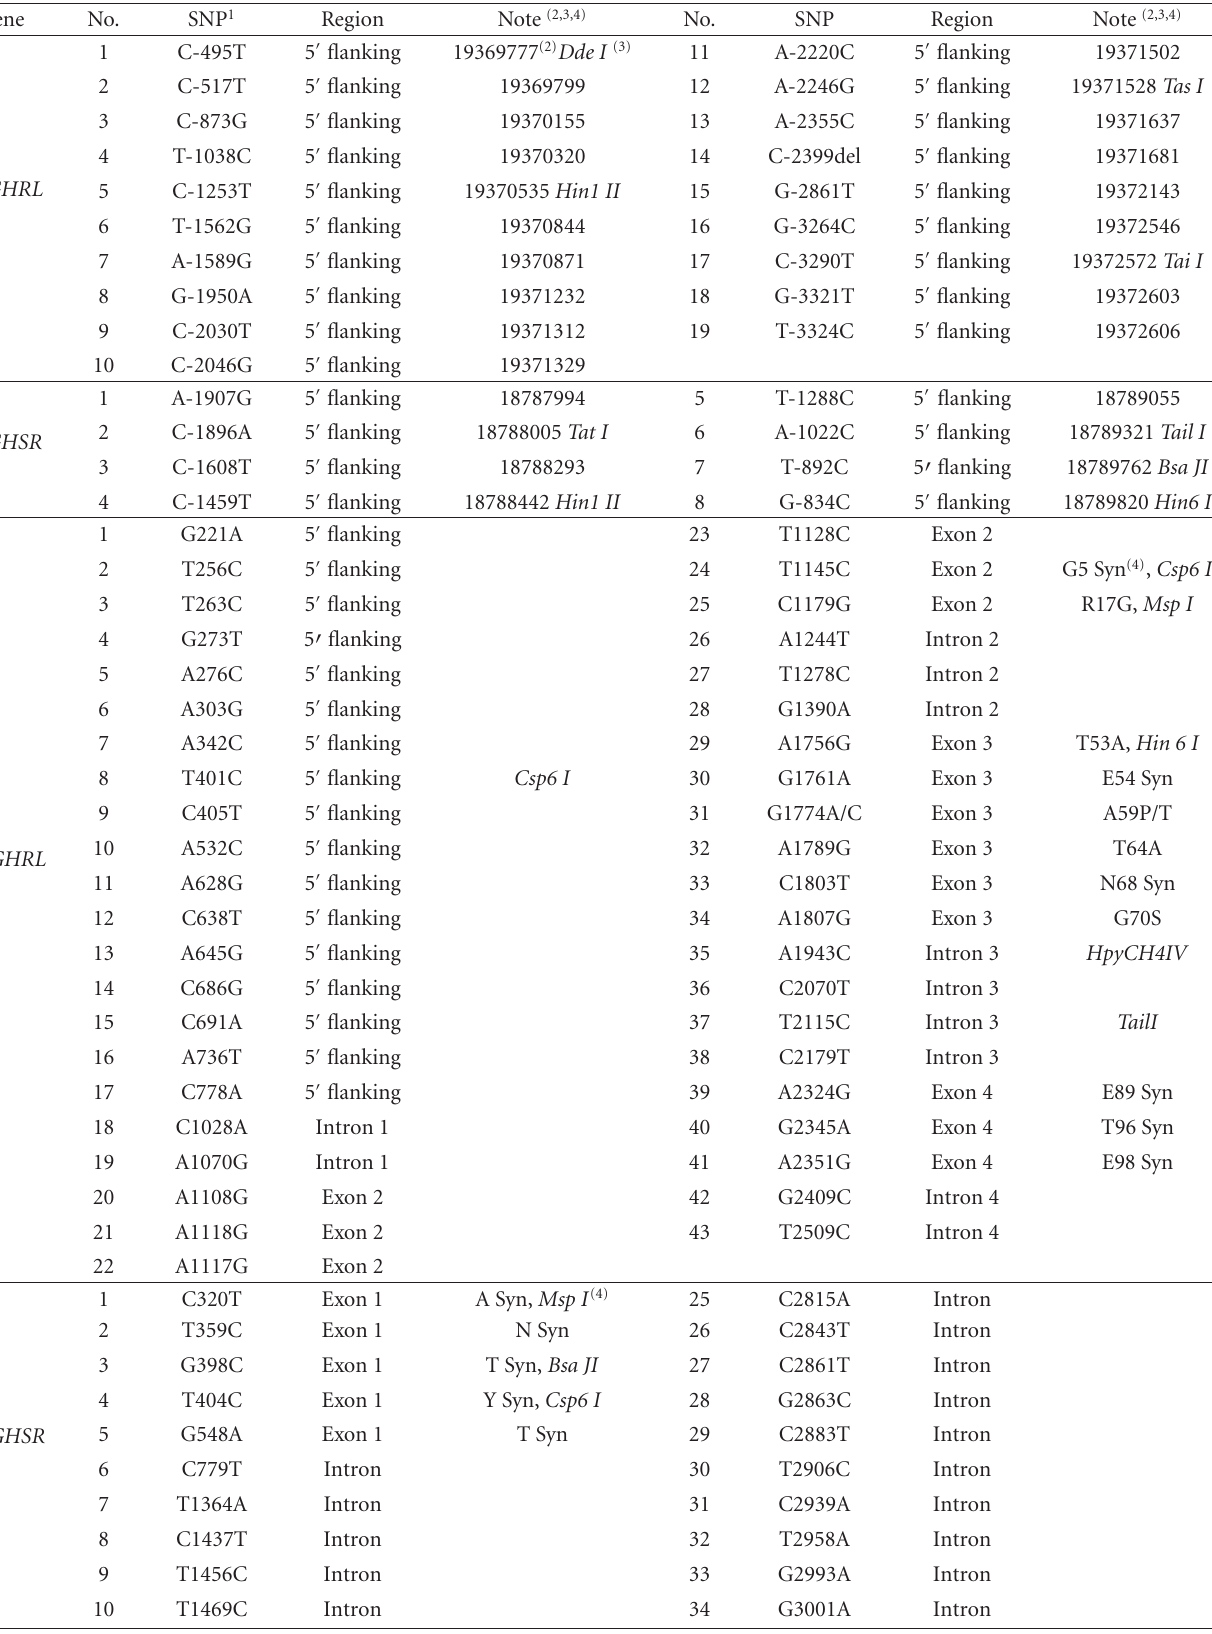
Table 3: SNPs identified in the cGHRL , cGHSR , dGHRL, and dGHSR